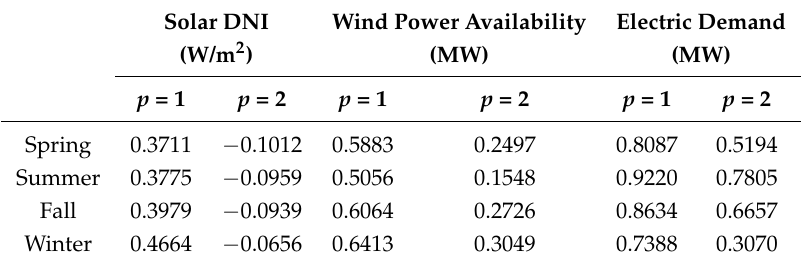
Table 1. Autocorrelations of Desired Process, X t , With Lag p